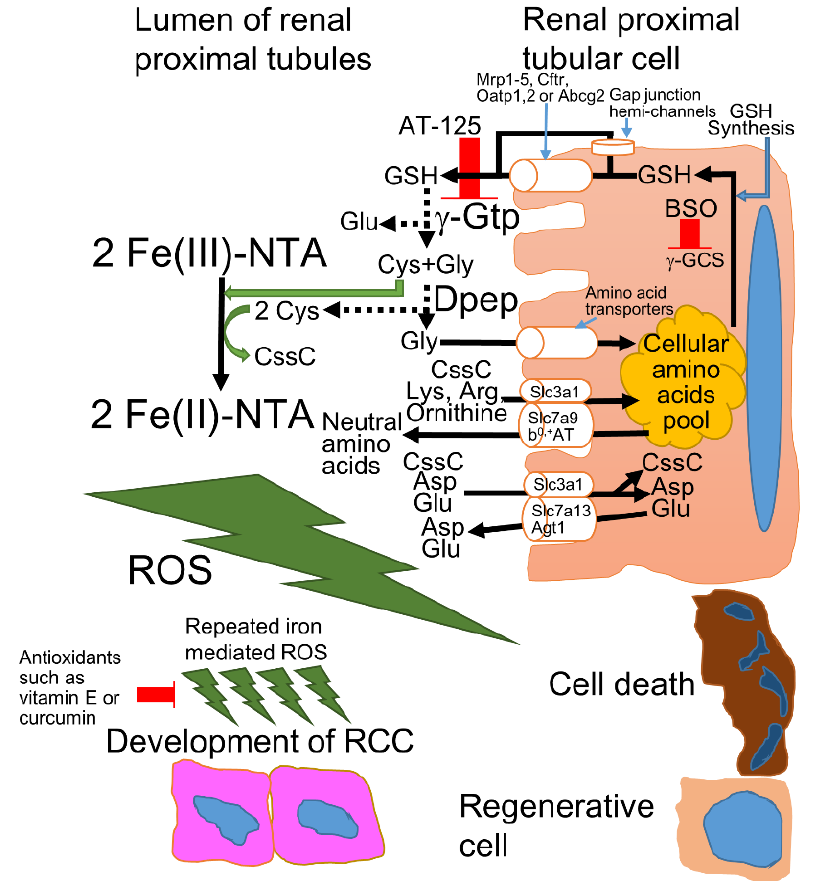
Figure 1. The mechanism of Fe-NTA-induced oxidative injury in the renal proximal tubules of rodents. Approximately 95–99% of all amino acids are reabsorbed in the proximal convoluted tubule and proximal straight tubule; thus, with very few exceptions, individual amino acids are transported by more than one transporter to provide backup capacity for absorption [34]. The intracellular GSH is exported from the cytoplasm to the lumen through GSH exporters, such as multidrug resistance-associated protein (Mrp) 1–5, cystic fibrosis transmembrane regulator (Cftr), organic anion transporting polypeptide (Oatp) 1 and 2, ATP-binding cassette superfamily G2 (Abcg2), or gap junction hemi-channels [27]. GSH is degraded by membrane-associated enzymes, such as γ -glutamyl transpeptidase ( γ -Gtp) [8,27]. The Cys-Gly can be degraded by membrane-bound dipeptidases (Dpep) [8,27] or imported to the cytoplasm directly by amino acid transporters [27,34]. Among the constituents of GSH, Gly is transported by many amino acids transporters [34], while Cys reduces Fe(III)-NTA to yield Fe(II)-NTA and cystine (CssC), triggering iron-dependent oxidative injury and carcinogenesis in the renal proximal tubules [8]. The CssC is transported into the cytoplasm via the related b 0 amino acid transporter/b 0,+ amino acid transporter (rBAT/b 0,+ AT), which is also called the Slc3a1/Slc7a9 complex, with anionic amino acids (Lys and Arg) and ornithine [34,35] or rBAT with Slc7a13, also known as aspartate/glutamate transporter 1 (Agt1), with cationic amino acids (Asp and Glu) [36]. In physiological conditions, more than 90% of CssC is reabsorbed via rBAT/b 0,+ AT, and the residual CssC is reabsorbed by rBAT/AGT1 in the renal proximal tubules [36]. The castrated male mice and female mice all survived, while all of the male mice died from repeated Fe-NTA injections in the A/J strain, indicating the sex differences against Fe-NTA-induced oxidative stress [37]. Indeed, the administration of testosterone in castrated male mice and female mice elevated renal lipid peroxidation to levels that were as high as those seen in male mice after Fe-NTA injection [37]. In contrast, estriol attenuated Fe- NTA-induced renal lipid peroxidation in male ddY mice [38]. Furthermore, castration and estradiol suppressed Fe-NTA-induced renal carcinogenesis; conversely, ovariectomy